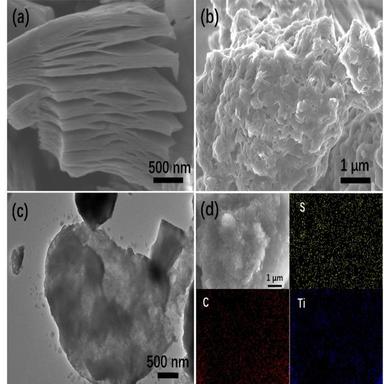
FESEM micrographs of (a) ML-Ti3C2, (b) ML-Ti3C2/Li2S. (c) TEM image of ML-Ti3C2/Li2S. (d) EDS elemental mapping images of ML-Ti3C2/Li2S and distribution of elements sulfur, carbon, and titanium.